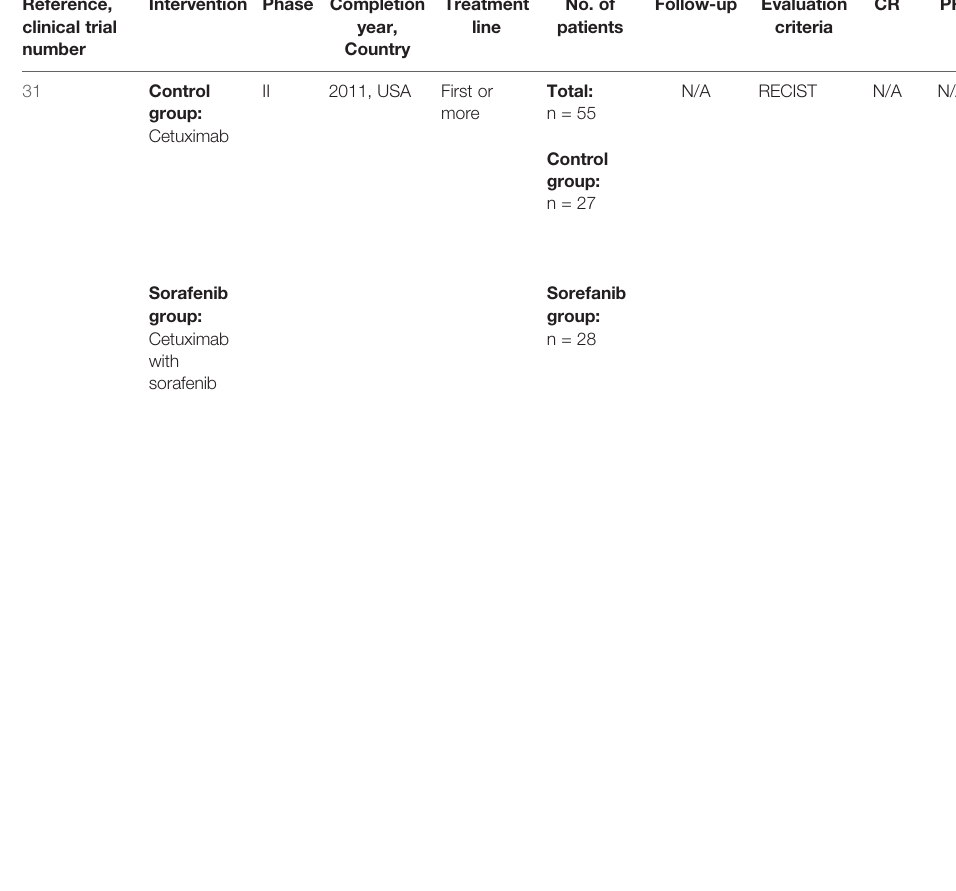
TABLE 2 | Summary of the sorafenib clinical trials for head and neck squamous cell carcinoma. Reference, clinical